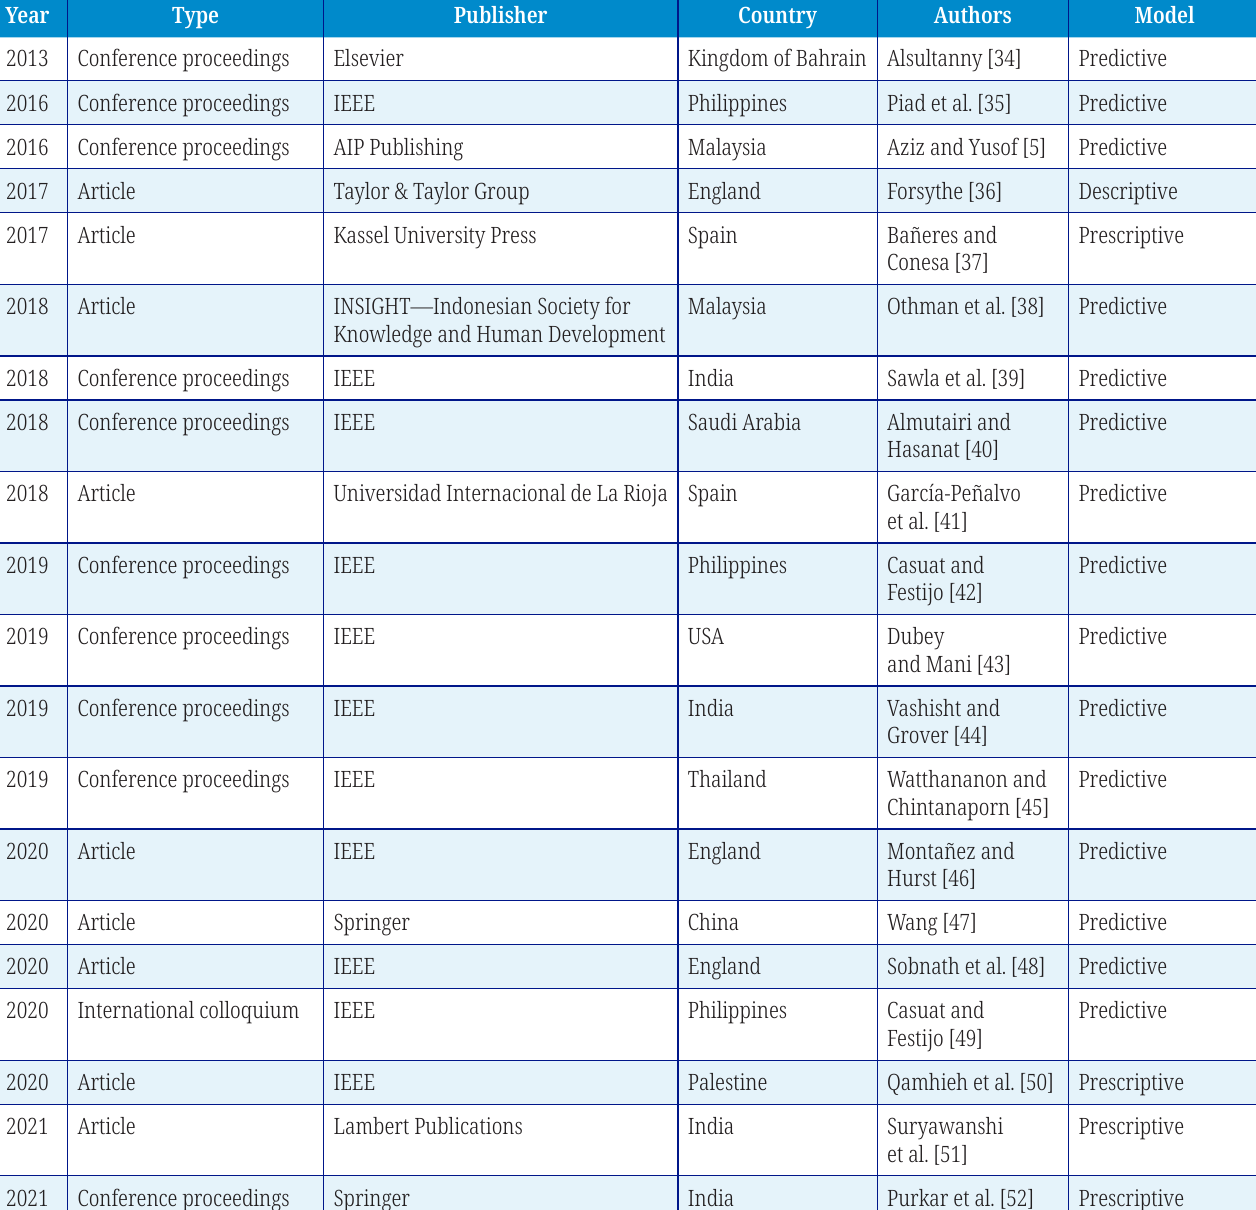
Table 3. Type of the paper, publisher, authors and countries where the research was